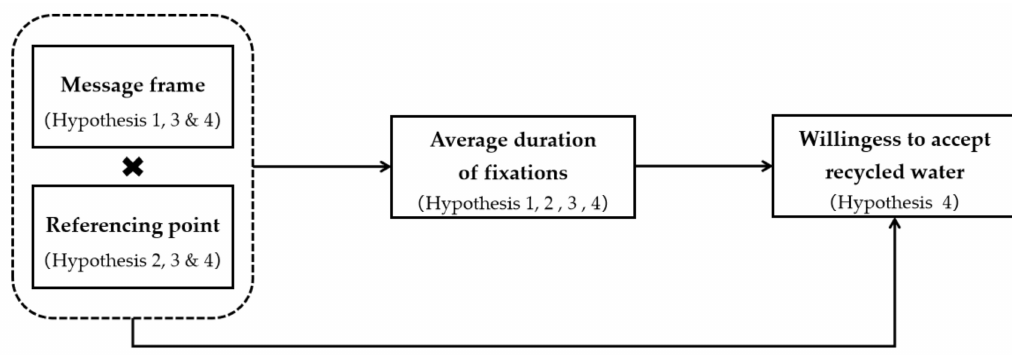
Figure 1. Research